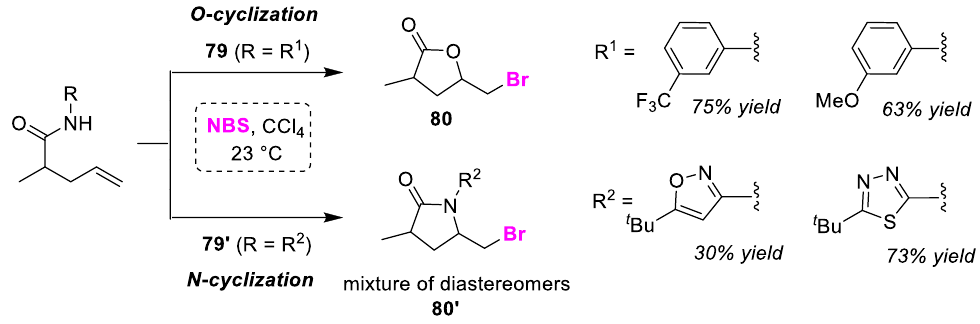
/ N atom-selective bromocyclizations of olefinic amides ( 79 and 79 (cid:48) Figure 38. Classical O/N atom-selective bromocyclizations of olefinic amides ( 79 and 7 9′ ). Figure 38. Classical O